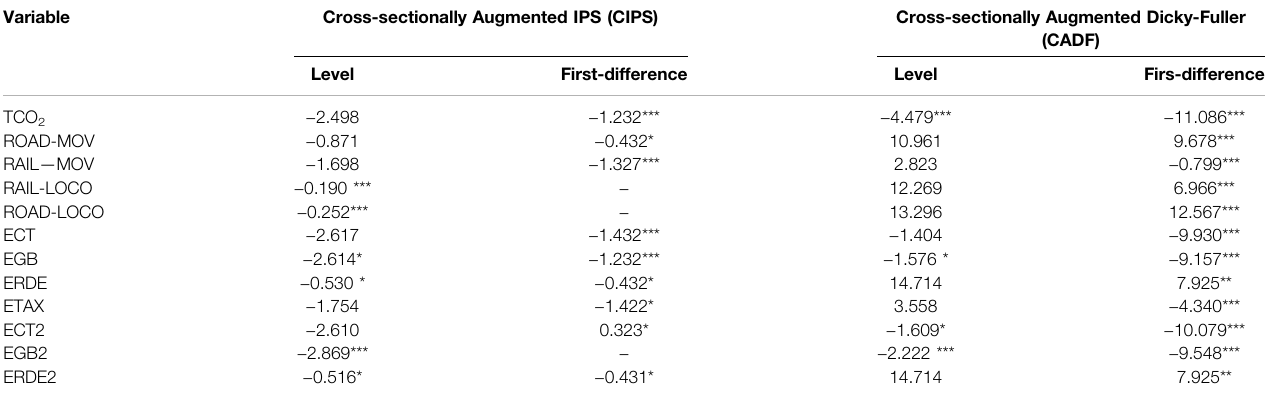
TABLE 4 | Panel Unit